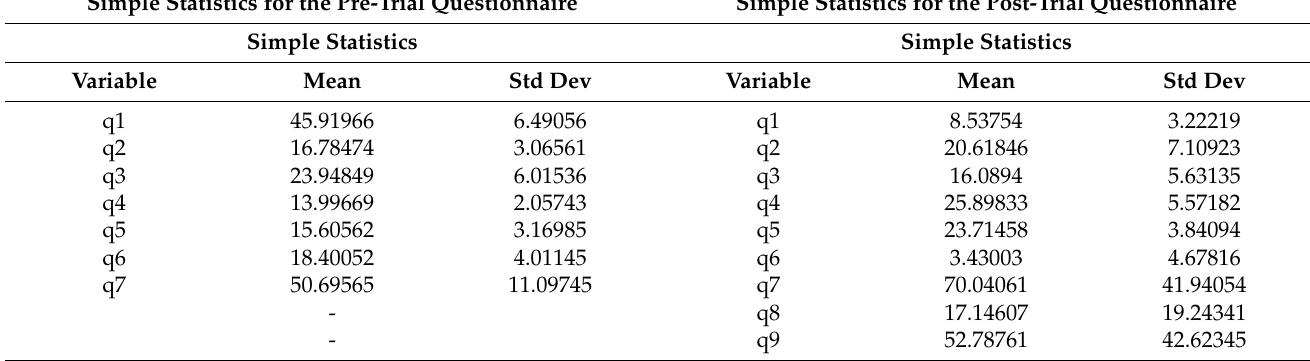
Table 5. Simple statistics for the two data